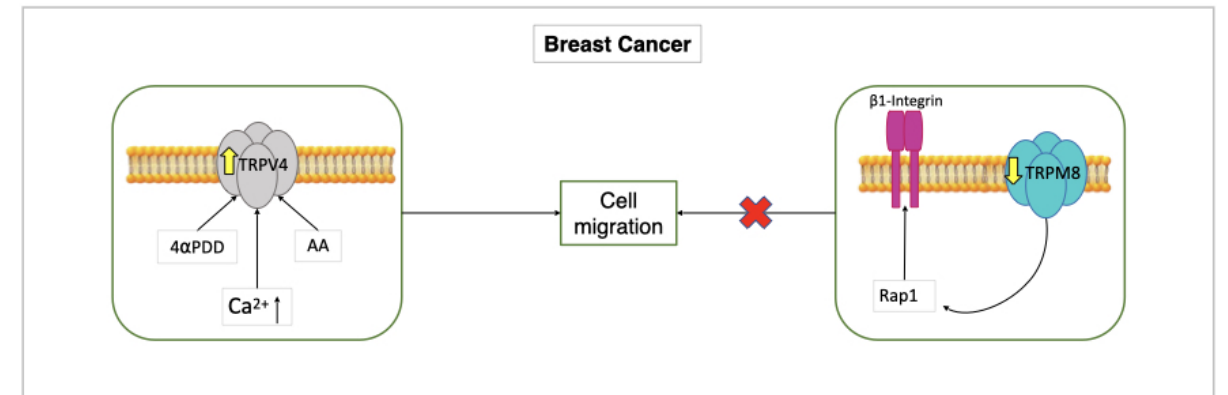
Figure 2. Role of TRPV4 and TRPM8 in B-TECs. AA or 4 α PDD induce increased expression of TRPV4 in B-TECs, resulting in increased migration of these and increased intracellular Ca 2+ entry. This shows that over-expression of TRPV4 induces the early stages of tumor